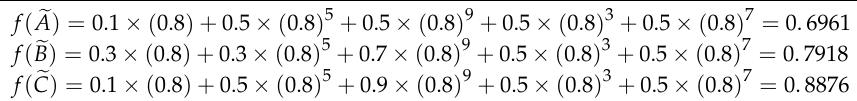
Table 1. Values of function f ( · ) for the fuzzy numbers (cid:101) A , (cid:101) B , and (cid:101) C .